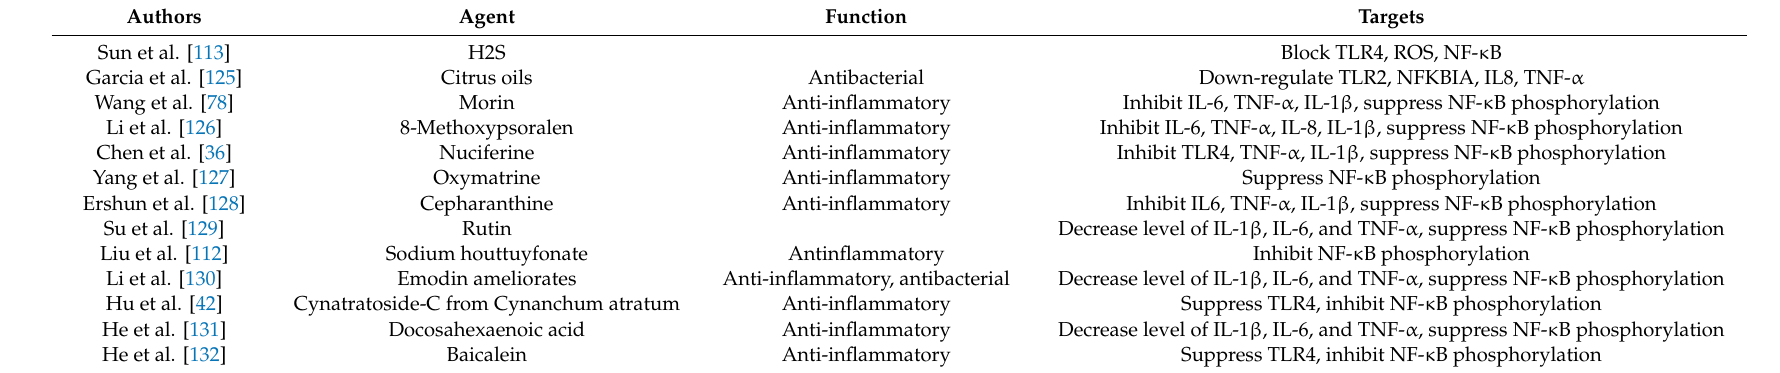
Table 1. Chemicals and their anti-inflammatory e ff ect in mastitis by suppression NF- κ B